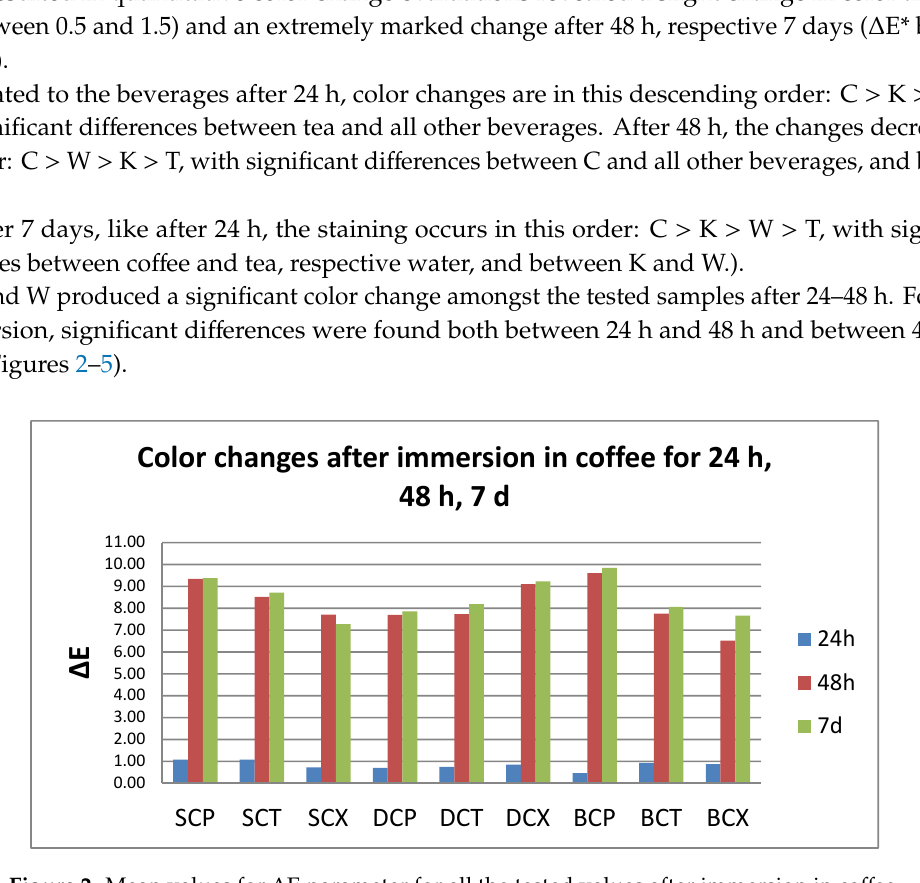
Figure 3. Mean values for ∆ E parameter for all the tested values after immersion in tea. Figure 4. Mean values for ∆ E parameter for all the tested values after immersion in Coca-Cola.